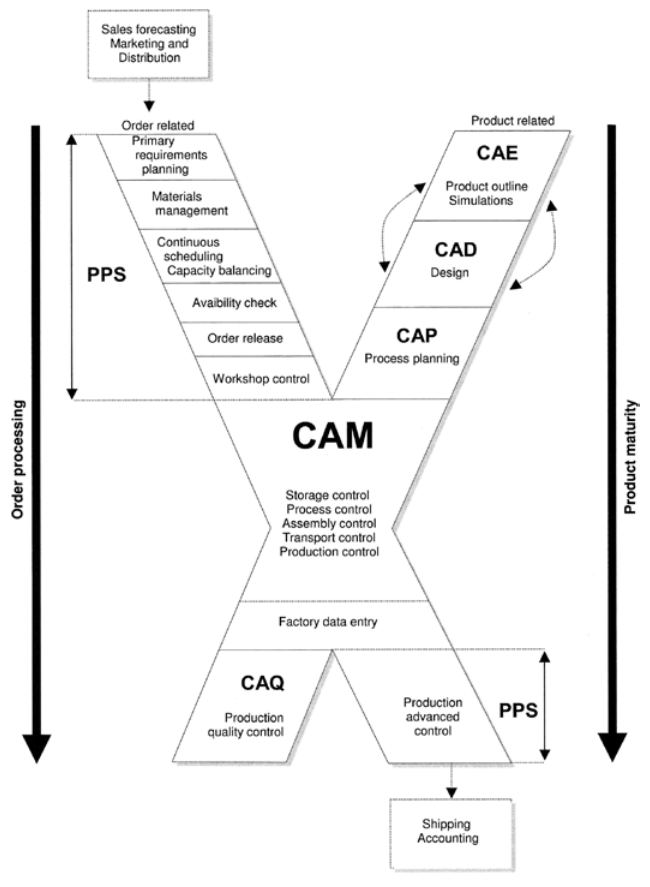
Figure 7: General Scheme of the